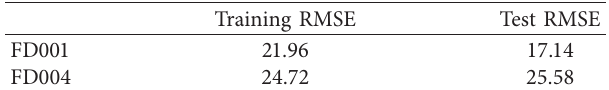
Figure 3: Sensibility analysis of the cost function by PDE penalty weight value λ . (a) FD001. (b) FD004. Table 1: Training and testing RUL RMSE values for models trained based on the proposed